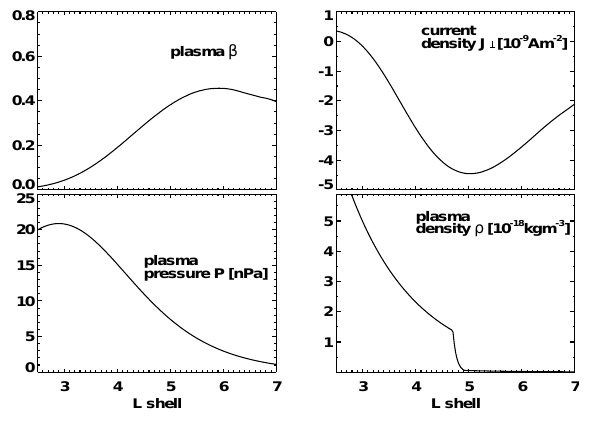
Fig. 10. Profiles of the poloidal eigenfrequencies f P (solid line ) and toroidal eigenfrequencies f T (dashed line) of magnetospheric field lines calculated for harmonic numbers N = 1 ,..., 4 and the mass correction factor m corr = 3. The dotted line marks the observed frequency f = 16mHz.The grey shaded background marks L-shells crossed by spacecraft C3 and C4 during the analyzed time